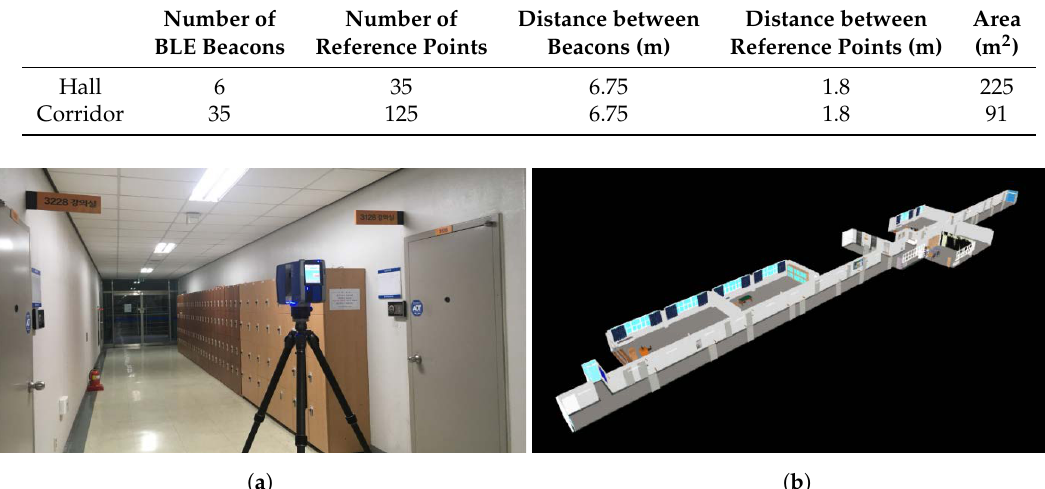
Figure 11. 3D indoor space map. ( a ) Indoor scanning to build the 3D map. ( b ) Sample of rendered 3D indoor